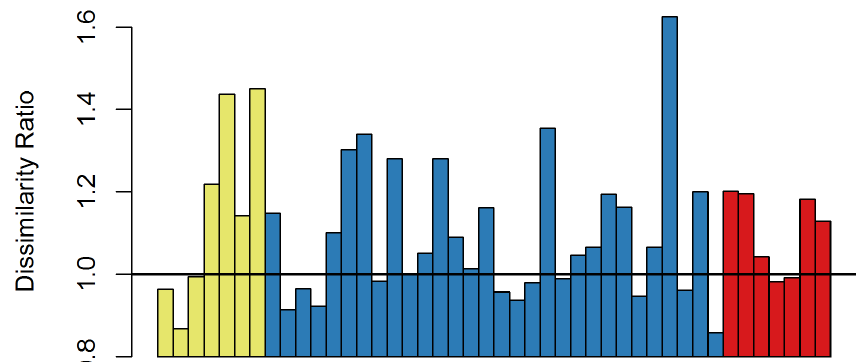
Figure 3. Dissimilarity ratio ([Bray-Curtis dissimilarity between 2007 site data and 2017 site data]/[Bray-Curtis dissimilarity between 2007 site data with ash individuals removed and 2017 site data]) for sites in Indiana (yellow), Michigan (blue), and Ohio (red). Values greater than 1.0